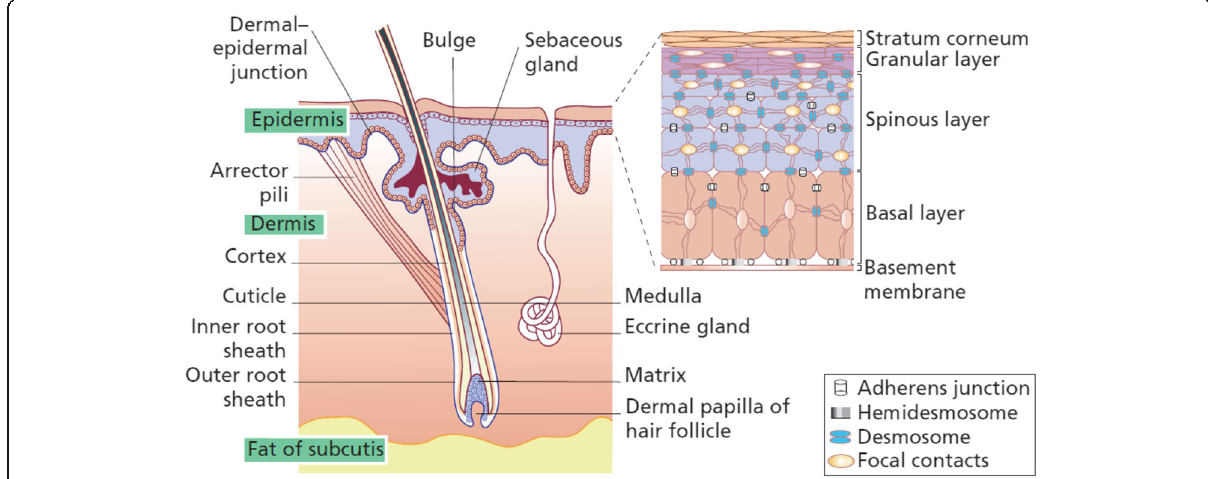
Fig. 1 The sketch of skin. Reprinted from ref. [15], Copywright (2004), with permission from Blackwell Publishing